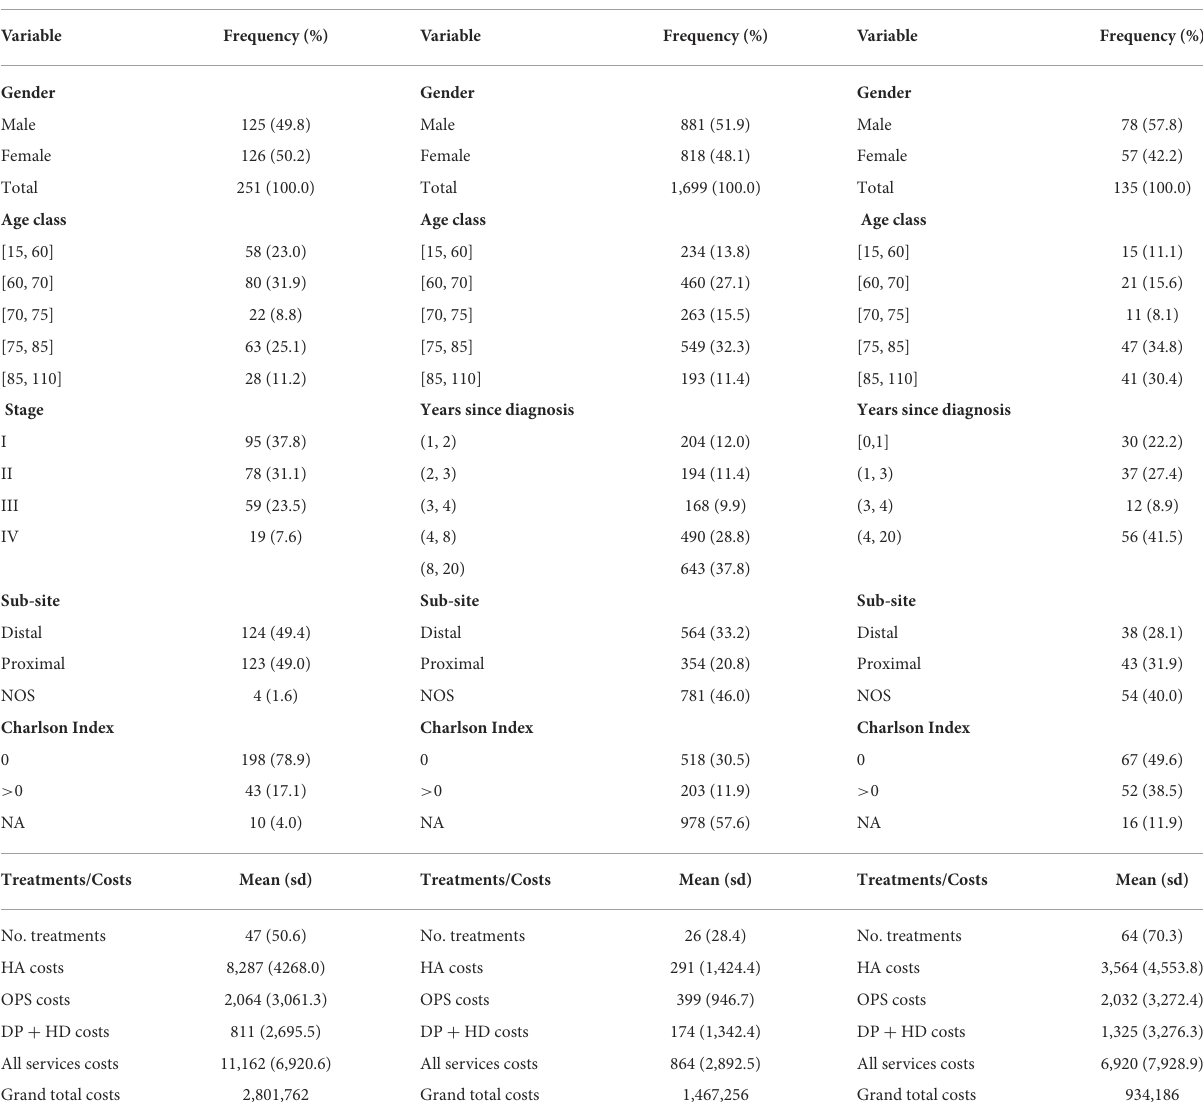
TABLE 1 Descriptive summaries of the cross-sectional study cohort, average patient costs by type of service, total costs of the study cohort (grand total cost), by phase of